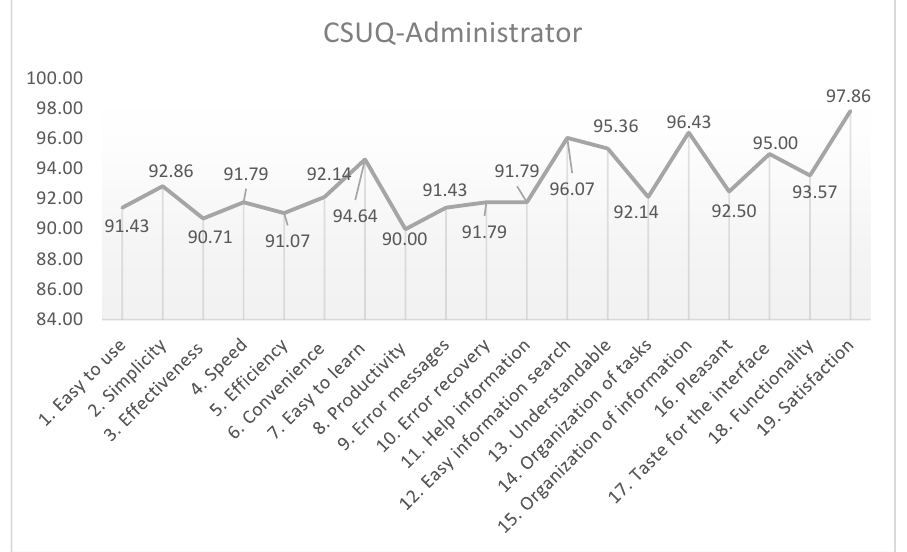
Figure 23. Administrator Role Answers-Averages per CSUQ Question.